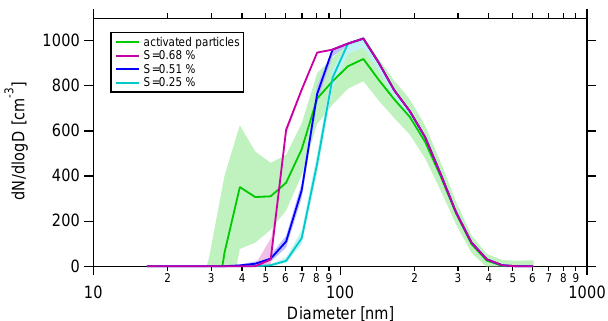
Figure 5. Average number size distribution of activated particles in the cloud (green) and CCN size distributions at S CCNC = 0.25, 0.51, and 0.68% (magenta, blue, and cyan). The shaded areas rep- resent the range of the statistical error of the individual data points.